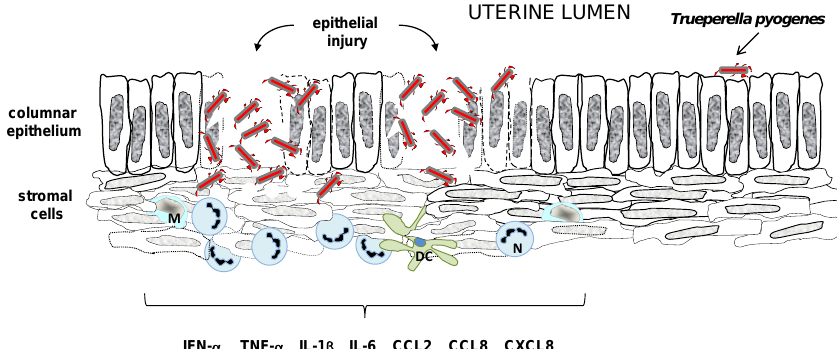
Figure 6. Schematic presentation of the pathogenesis of uterine infection with T. pyogenes . Recruitment of monocytes (M), neutrophils (N), dendritic cells (DC), and other proinflammatory cells—secretion of proinflammatory